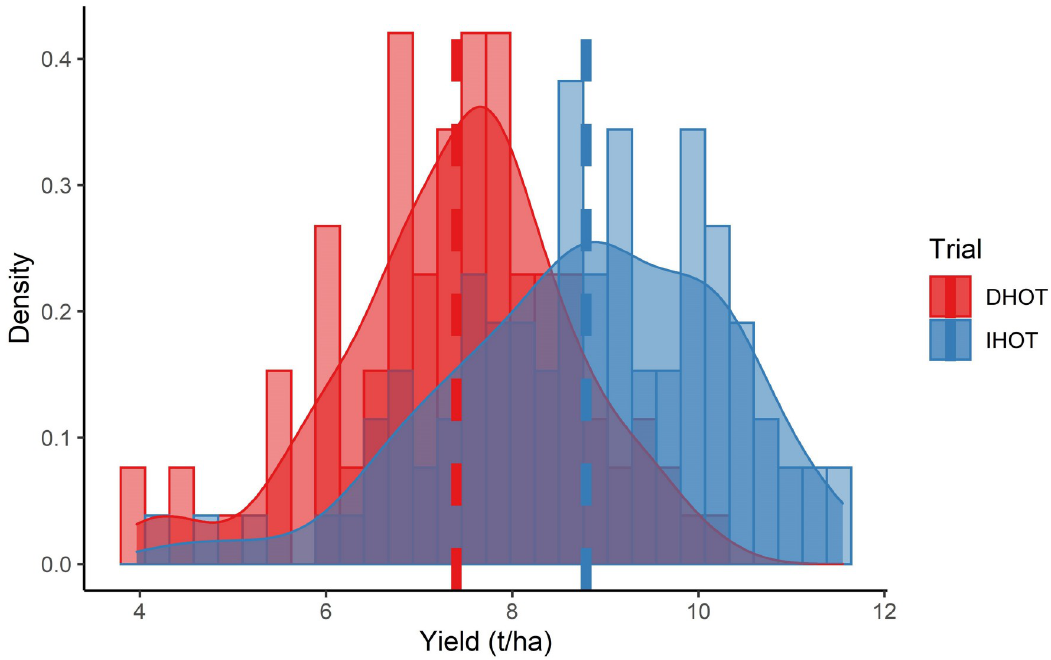
Fig 2. Average crop yield density, as well as histogram, plots, per trial. The Y-axis shows the density of yield, whereas the X-axis shows the grain yield in tons per hectare.